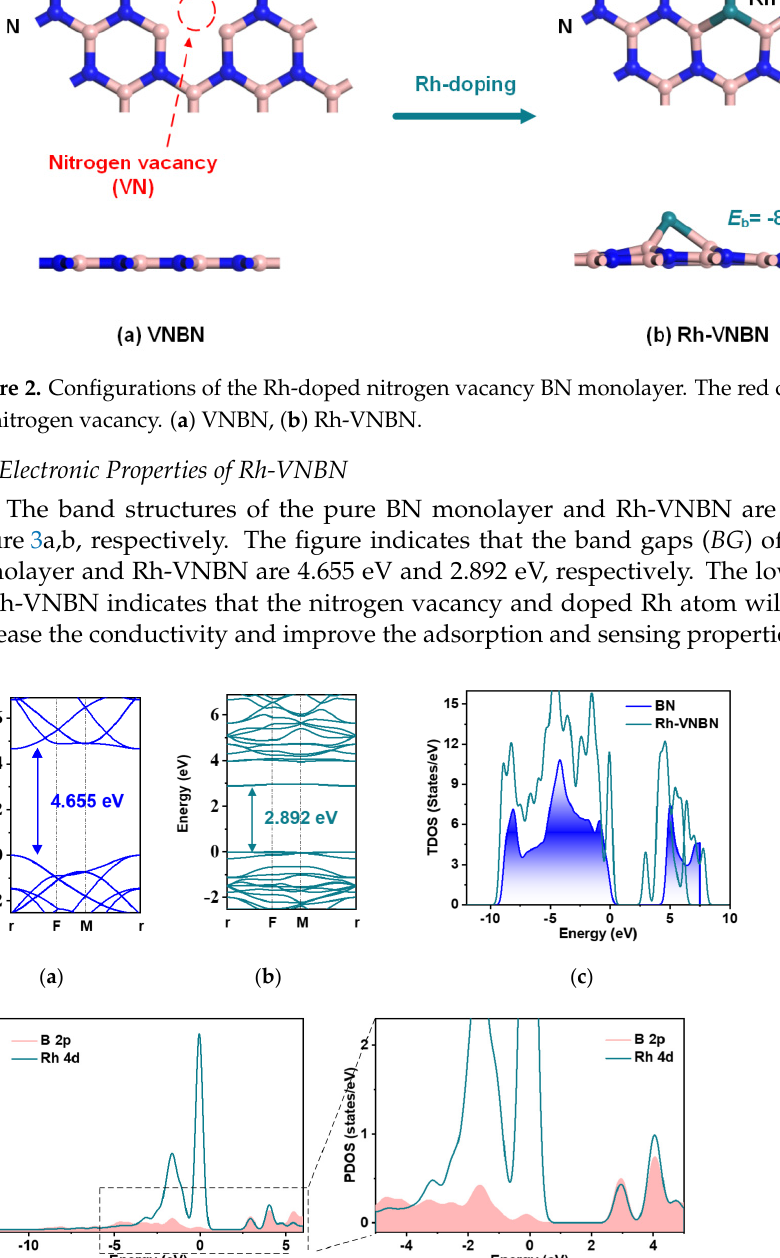
Figure 2. Configurations of the Rh-doped nitrogen vacancy BN monolayer. The red circle represents the nitrogen vacancy. ( a ) VNBN, ( b ) Rh-VNBN.